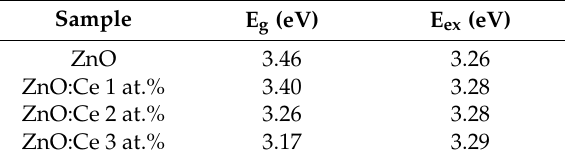
Table 2. The dependence of the band gap and exciton energy on the Ce content. Sample